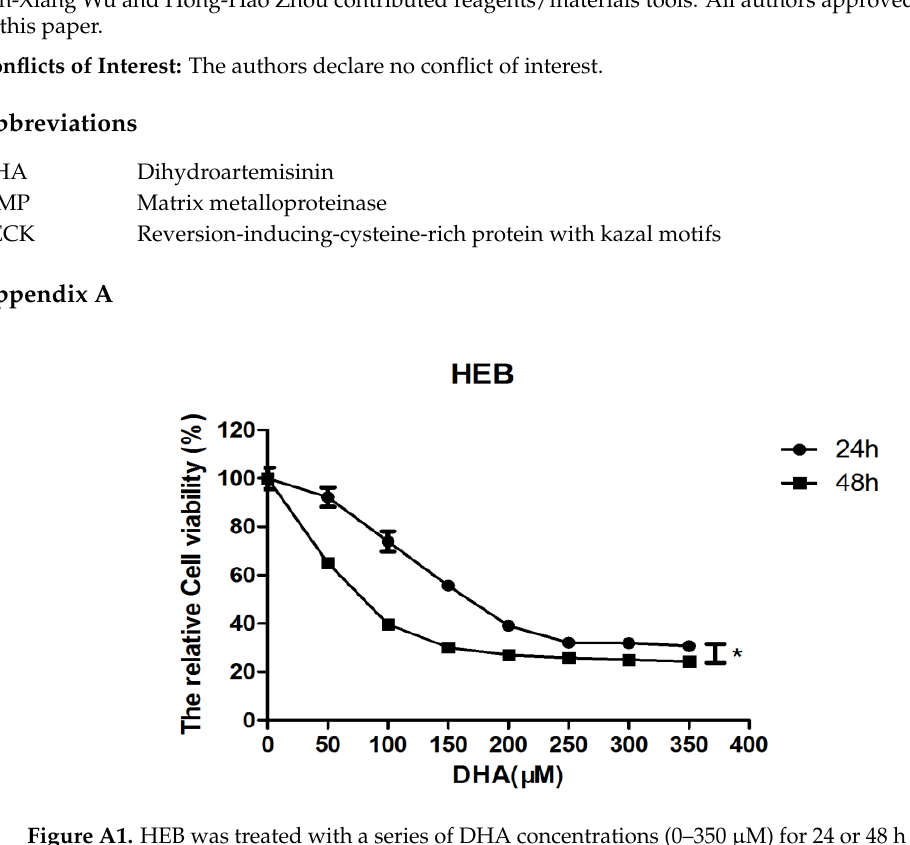
Figure A1. HEB was treated with a series of DHA concentrations (0–350 µ M) for 24 or 48 h followed by MTT assay. Values were mean ± SD ( n = 3). * p < 0.05 as compared with negative control cells.